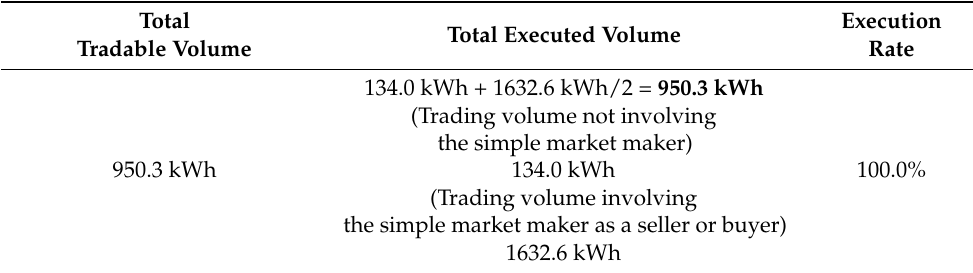
Table 6. Total volumes in the simulation with the simple market maker.